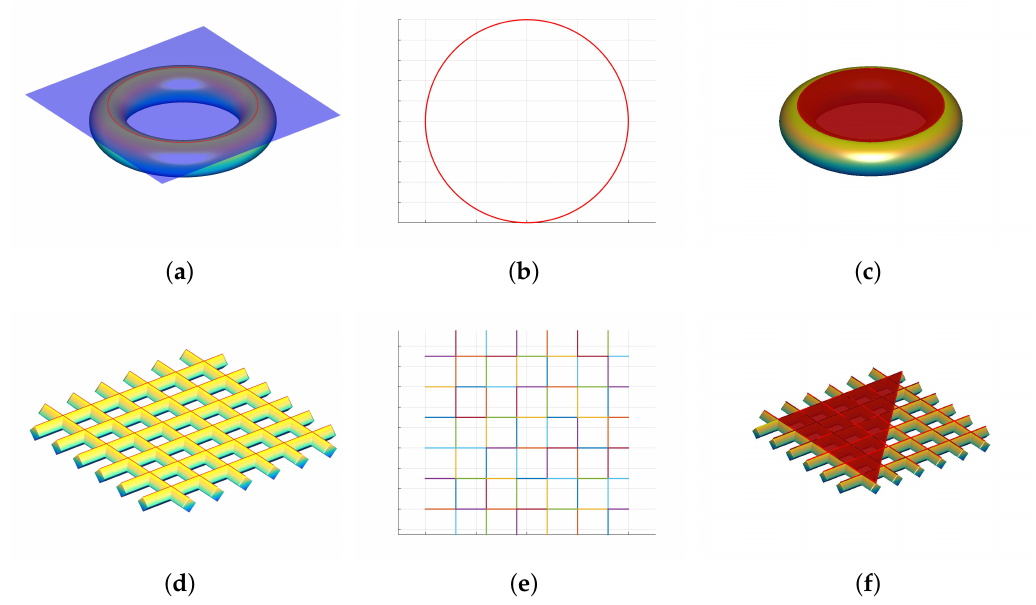
Figure 6. First column: Degenerate datasets Lying Torus and Grid used as input. Second column: correct level sets computed by our algorithm. Third column: Incorrect results produced by naive Morse slicer. ( a ) Lying Torus dataset; ( b ) Correct uppermost level set of Lying Tours , being a 0-width annulus S NO ; ( c ) Incorrect uppermost level set of Lying Torus , being a full disk; ( d ) Correct uppermost level set of Grid , being a set S NO of non-oriented polylines with borders; ( e ) Grid dataset; ( f ) Incorrect uppermost level set of Grid